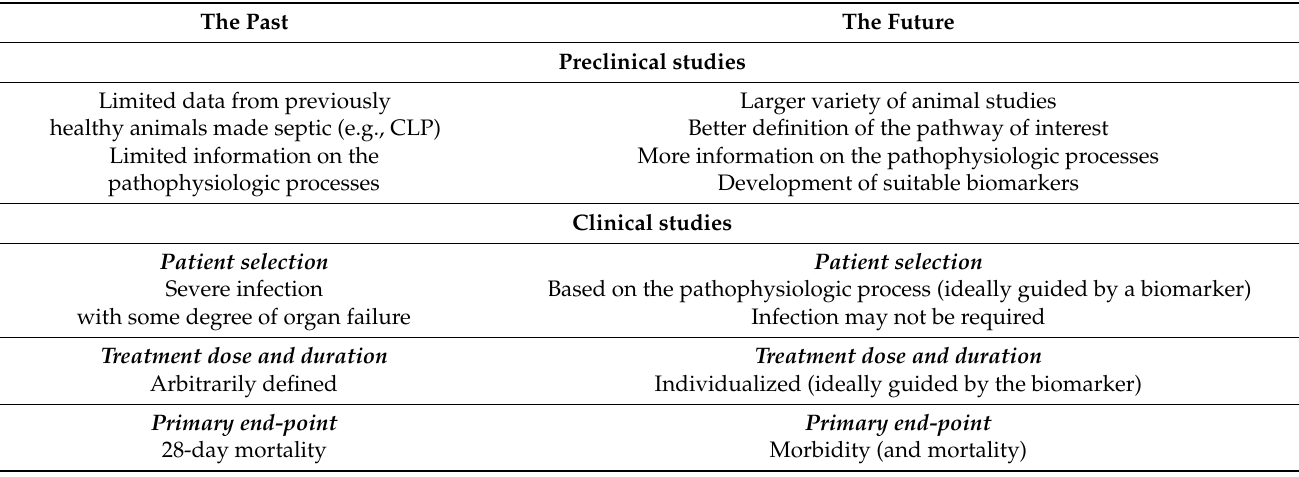
Table 2. Future evolution of “sepsis”